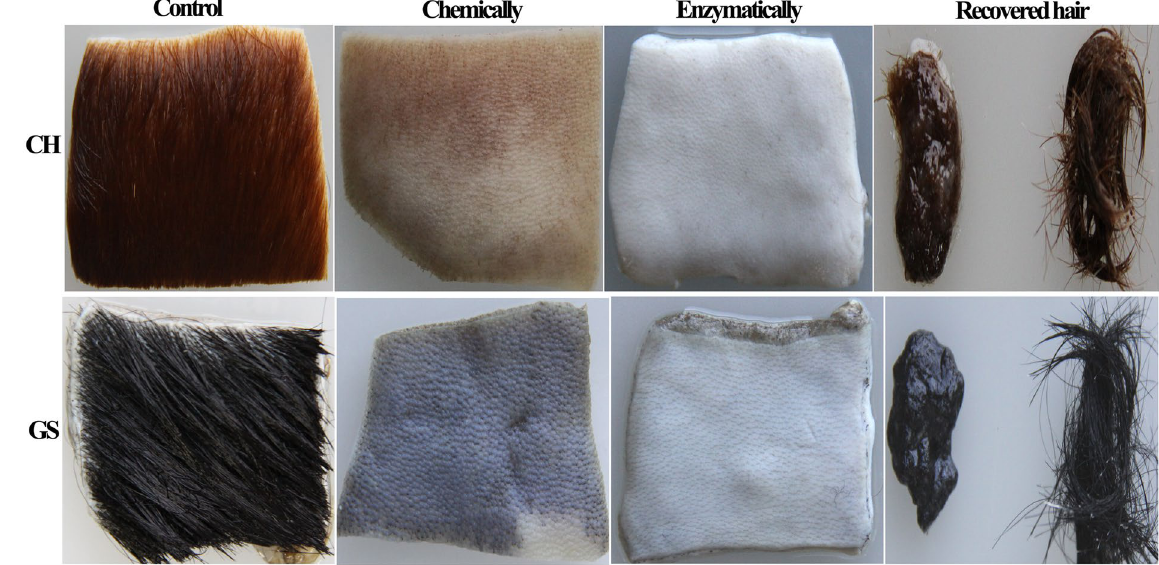
Figure 7. Dehairing effect by conventional chemical treatment versus enzymatic method with crude AprA- PPC. CH represents cattle hide; GS represents goat skin. The dehairing treatment was performed at 40 °C for 10–12 h. In the picture of recovered hair, chemical dehairing result is shown in the left, whereas enzymatic dehairing result is shown in the right.